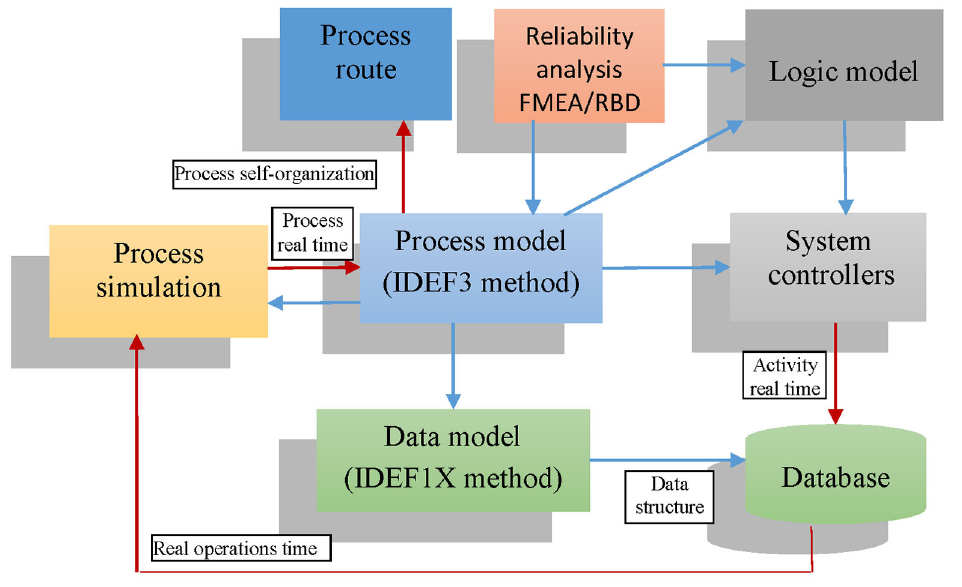
Fig. 3. Modelling centred approach for process